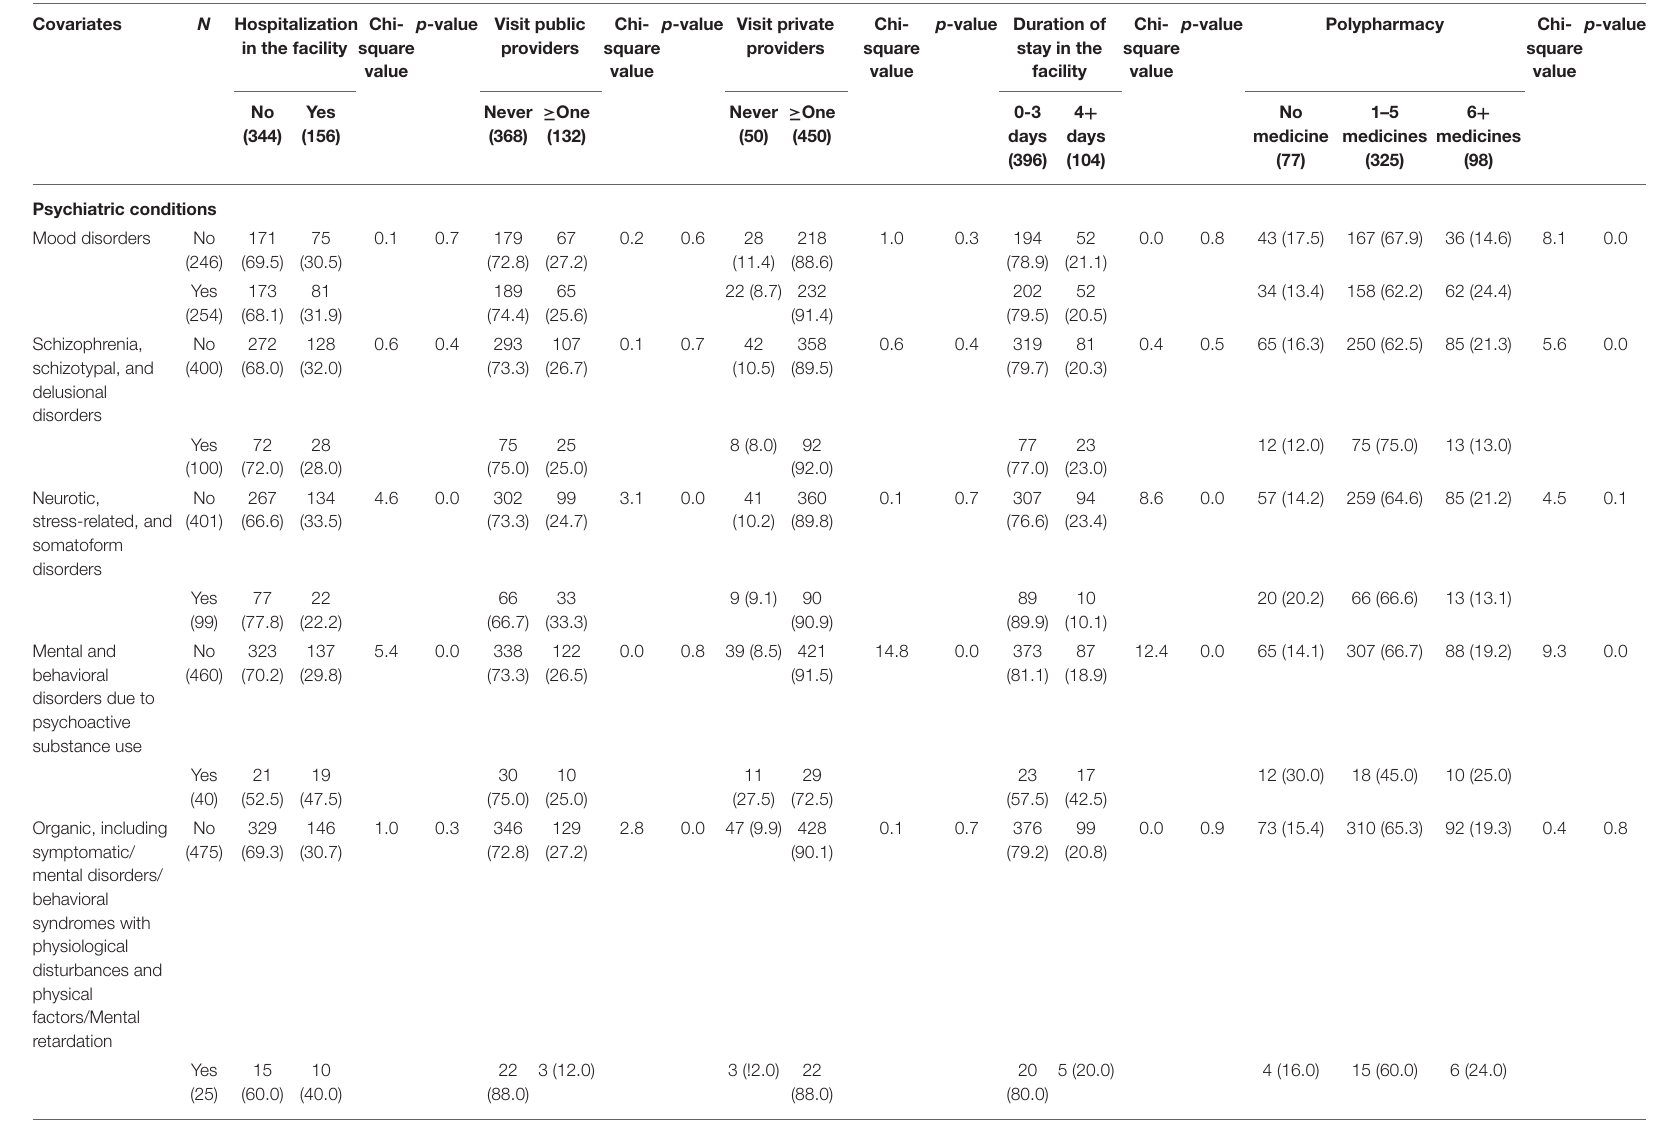
TABLE 5 | Association between the morbidity conditions (Psychiatric + Somatic) and healthcare utilization.